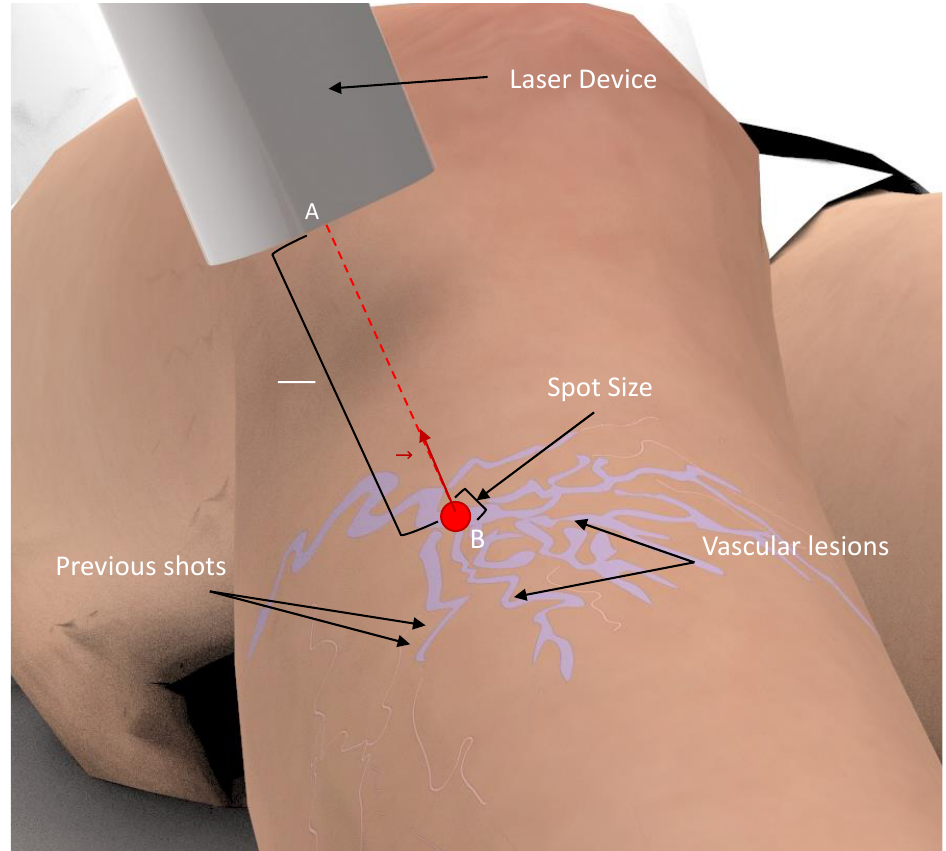
Figure 1. Laser treatment representation. During treatment, the laser device must be manually handled while keeping the correct distance ( AB ) and perpendicularity ( Moreover, overlapping shoots must be avoided while maximizing the treated area of the lesion. The laser light source is represented by A. The red dot and B represent the laser projection position on the patient’s